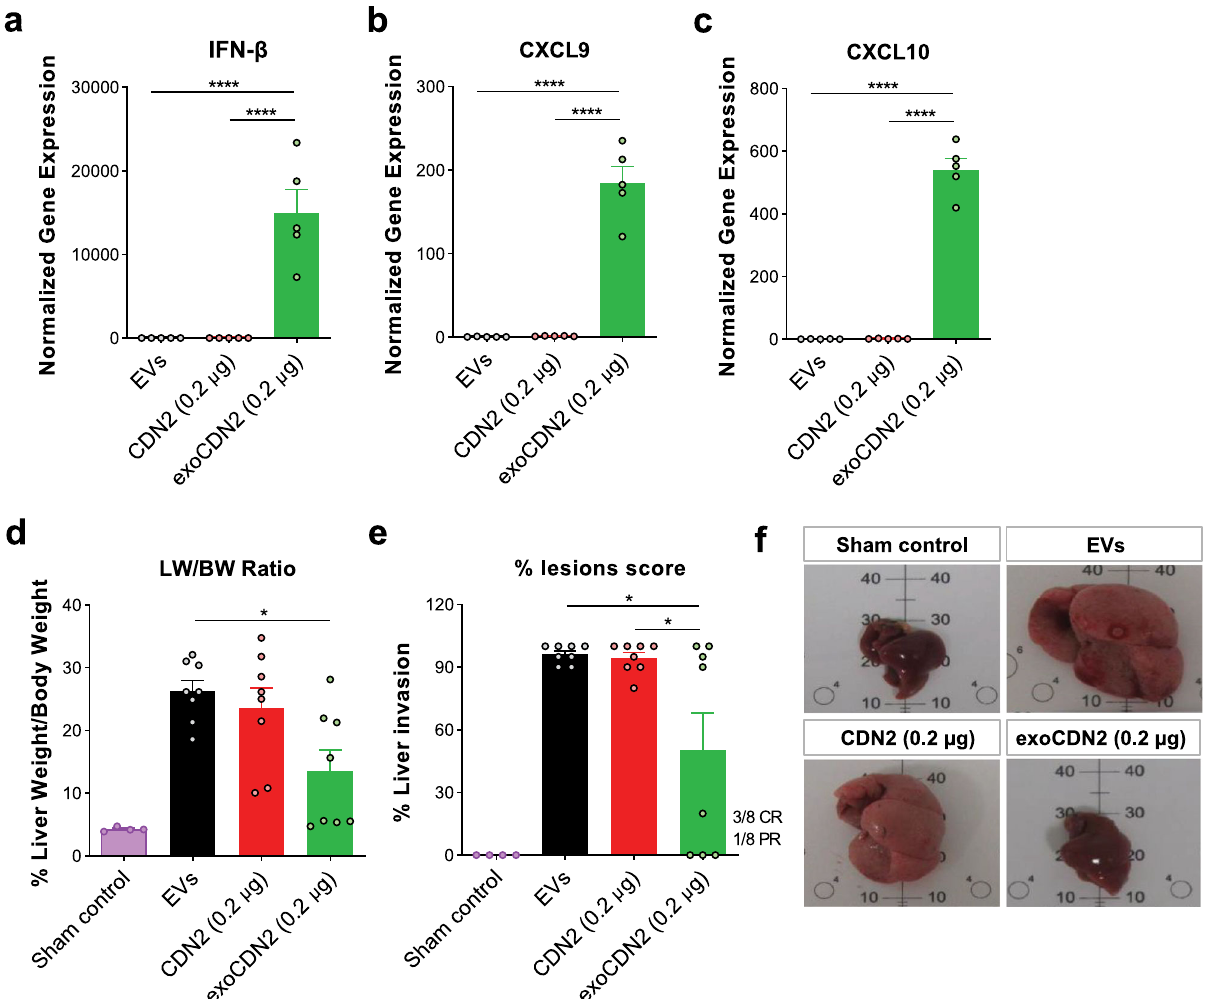
Fig. 8 Systemic administration of exoSTING enhances pharmacodynamic response and anti-tumor activity of a CDN. a – c Four hours after IV injection, RNAs were puri fi ed from livers ( n = 5 animals per group). Relative expression of IFN- β ( a ), CXCL9 ( b ), and CXCL10 ( c ) genes was measured by RT-qPCR, normalized against the housekeeping gene RPS13 . d – f Orthotopic hepatocellular carcinoma was induced by injecting 1.5 × 10 6 Hepa1 – 6 cells into spleen. Unloaded EVs, CDN2 (0.2 μ g), and exoCDN2 (0.2 μ g) were injected intravenously at Day 4, 7, and 10 after cell injection ( n = 8 animals per group). At Day 15, mice were sacri fi ced, and livers were collected. Liver weight (LW) over body weight (BW) was calculated ( d ) and % lesions scores were evaluated ( e ). Representative liver images were taken ( f ). Data are presented as means ± s.e.m from replicate samples as indicated. * P < 0.05; **** P < 0.0001 by one-way ANOVA with Tukey ’ s multiple comparison